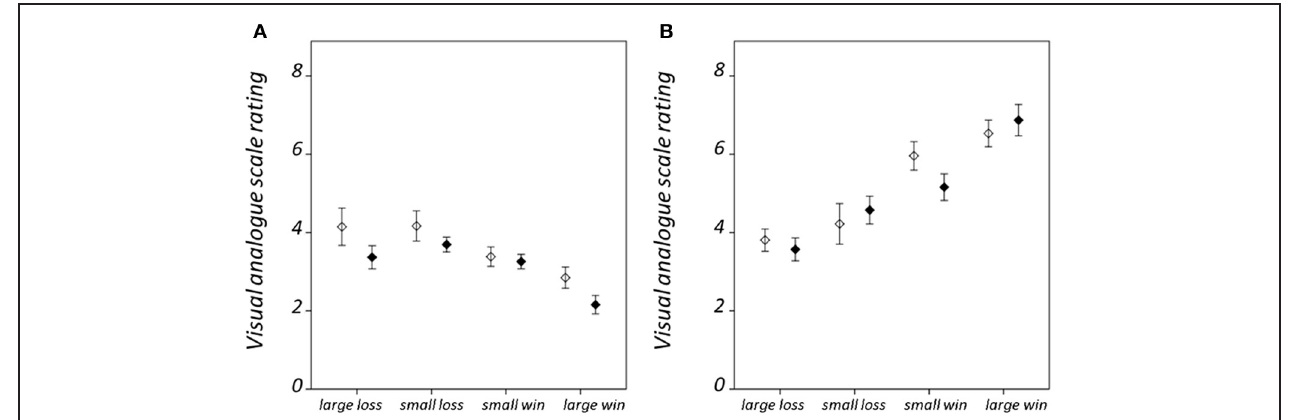
FIGURE 3 | Condition-specific visual analog scale (VAS) rating results. For (A) hit trials, and (B) miss trials. VAS ratings range between 1 when the participant reported feeling “satisfied” and 9